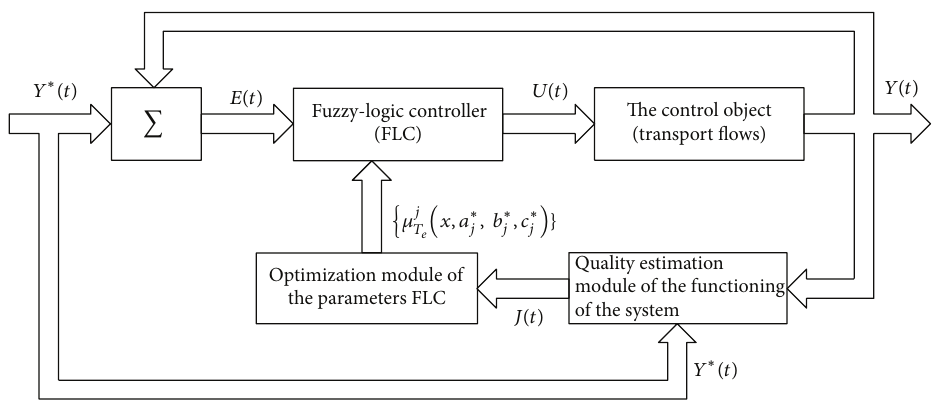
Figure 1: A traffic control system at the crossroads with an adaptive fuzzy-logic